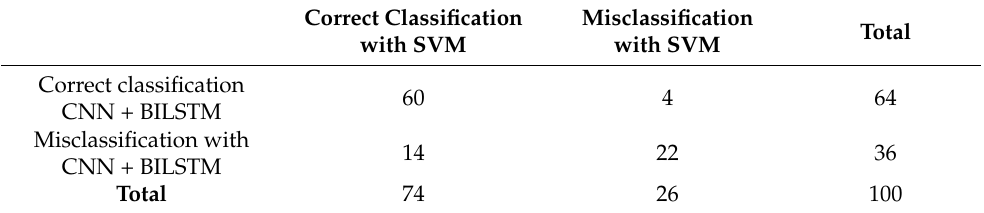
Table 12. Significant differences between the SVM (ML) and CNN + BILSTM (DL)